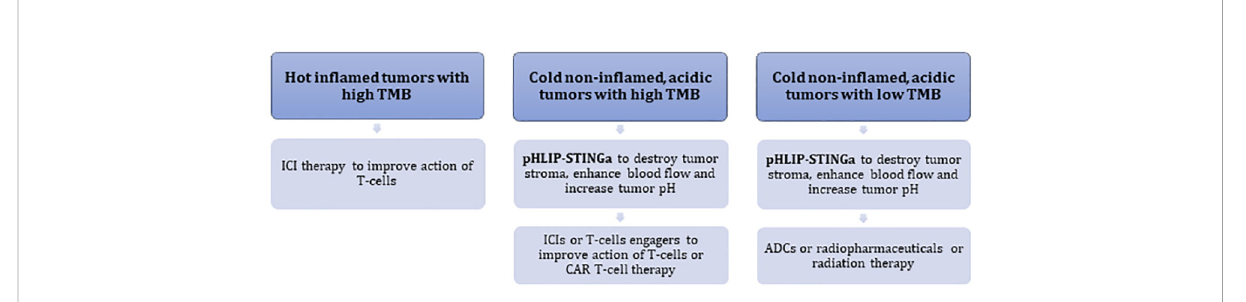
FIGURE 5 Schematic presentation of different types of tumor development and treatment